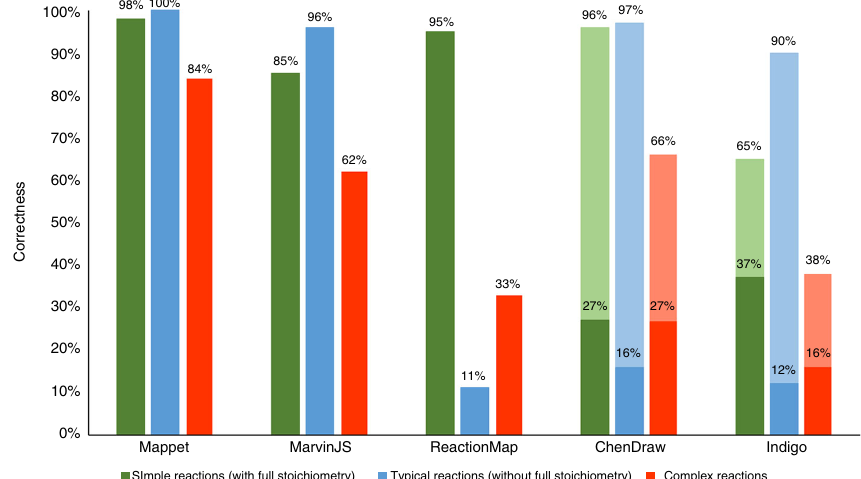
Fig. 5 Performance of various mappers quanti fi ed on the 401 reactions from the main test set. For ChemDraw and Indigo, solid parts of the bars correspond to the more stringent criterion that all atoms in the molecule must be assigned numbers. Shaded parts of the bars give the percentages of correct answers assuming a more lenient criterion allowing for unmapped but chemically unique atoms (see examples in Supplementary Fig. 6). ReactionMap does signi fi cantly better (~71%) on complex reactions with full stoichiometry (see main